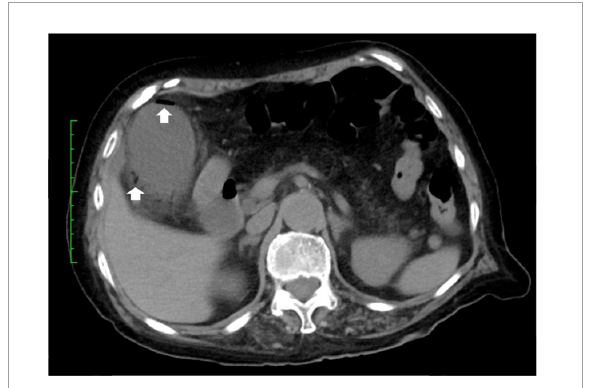
FIGURE1 CT-scan of the abdomen. Abdominal CT showing air in the walls (arrows) of the gallbladder.